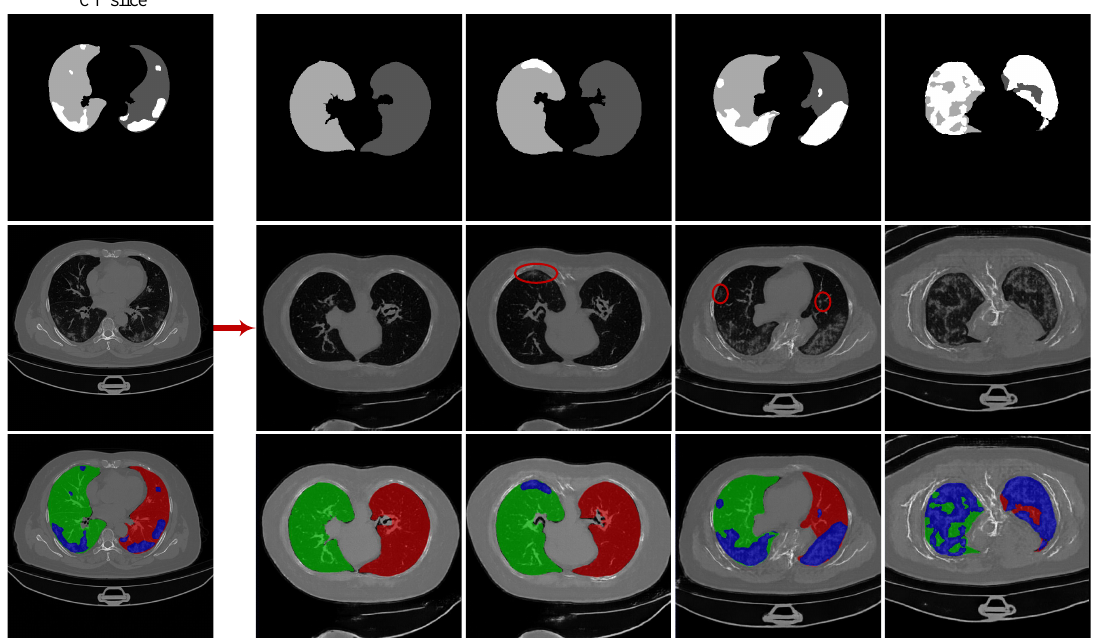
Figure 3. High-resolution (512 × 512) synthetic radiological images from proposed CoSinGAN. CoSinGAN is a novel conditional generative model trained on a single chest CT slice. Our model is able to capture the conditional distribution of visual finds of the lungs and COVID-19 infection accurately. We explore the feasibility of learning deep models for automated lung and COVID-19 infection segmentation from a single radiological image by resorting to synthesizing diverse radiological images. Both 2D U-Net and 3D U-Net trained on synthetic images achieves notable segmentation performance. The first row denotes the input conditions, where the white and gray (e.g., light gray and dark gray) represent the infected regions and lungs, respectively. The last row denotes synthetic CT slices with input condition overlays, where the blue denotes infected regions and the red (or green) represents the